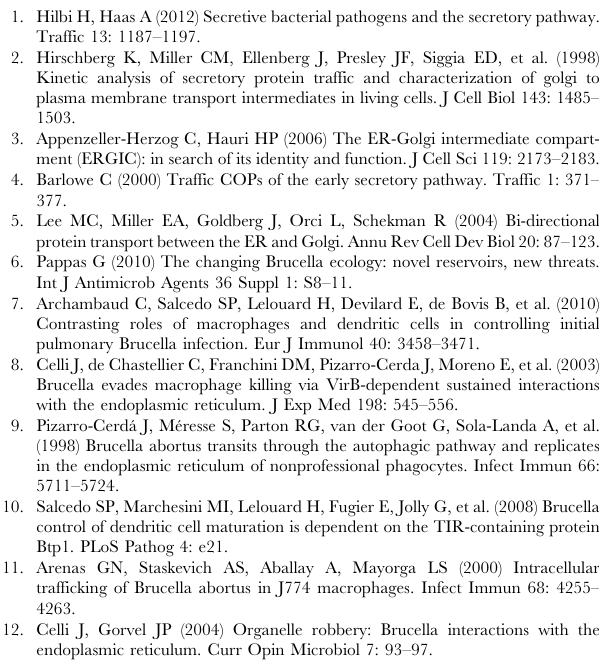
Figure S10 Effect of single or combined deletions of bspA , bspB and bspF on infection and persistence of Brucella in mice. Groups of five 6–8 weeks old BALB/c female mice were infected intraperitoneally (i.p.) with approximately 1 6 10 5 CFUs of B. abortus strain 2308 and its isogenic mutant strains. On day 3, 7 and 42 mice were euthanized, and splenomegaly (A and B) and bacterial loads in spleens (C and D) and livers (E and F) were examined. Asterisks indicate a statistically significant difference (P , 0.05) as determined by a one-way ANOVA analysis followed by the Tukey’s test. Table S1 List of predicted B. abortus proteins of unknown functions fulfilling search criteria for putative VirB T4SS effectors. Table S2 List and features of B. abortus putative VirB T4SS effector proteins. Table S3 Primers and plasmids used in this study. Table S4 Primers used to construct and confirm Brucella in- frame deletion